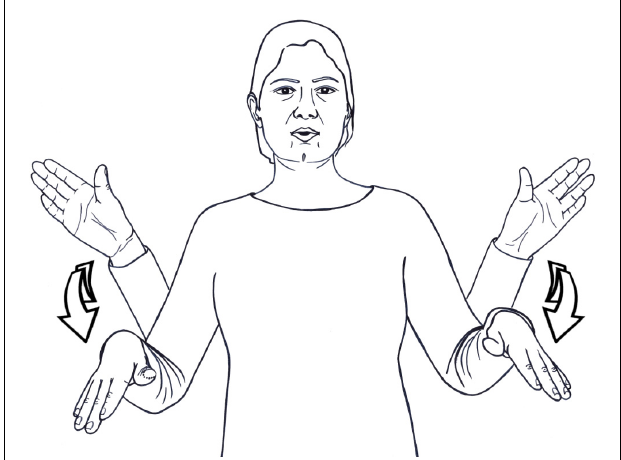
FIGURE 3 | The iconic ISL sign FLY, highlighting the manner of